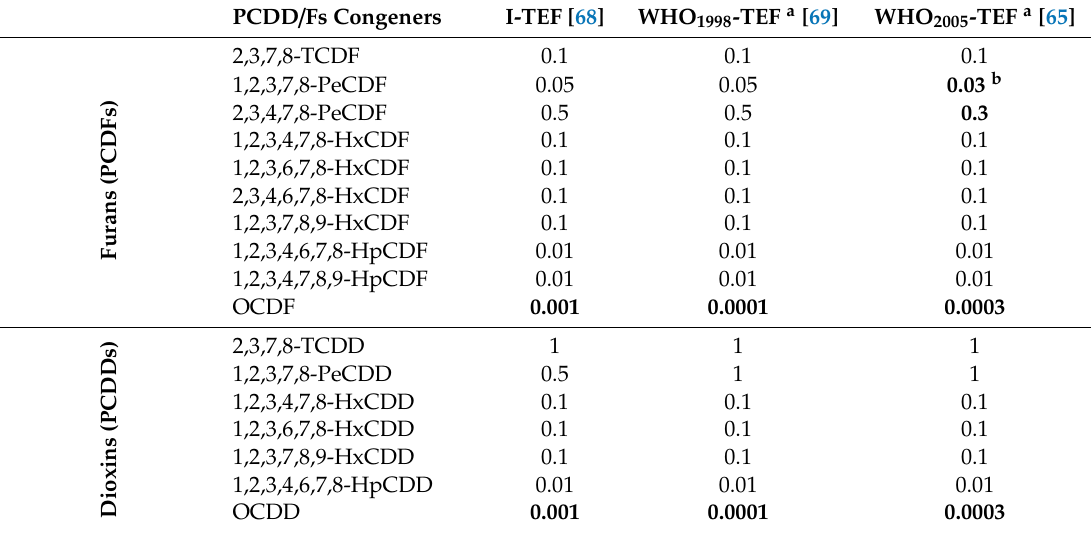
Table 1. List of 17 polychlorinated dibenzo-p-dioxins and polychlorinated dibenzofurans (PCDD / Fs) congeners and Toxic Equivalent Factors (TEFs) for Toxic Equivalents (TEQ) calculations. PCDD / Fs Congeners I-TEF